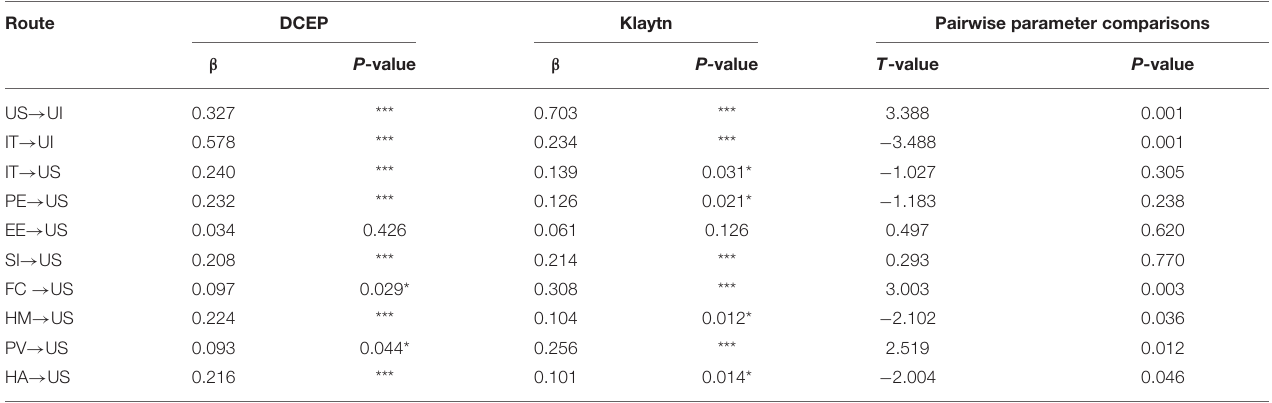
TABLE 7 | The path coefficients’ difference between China and Korea users.